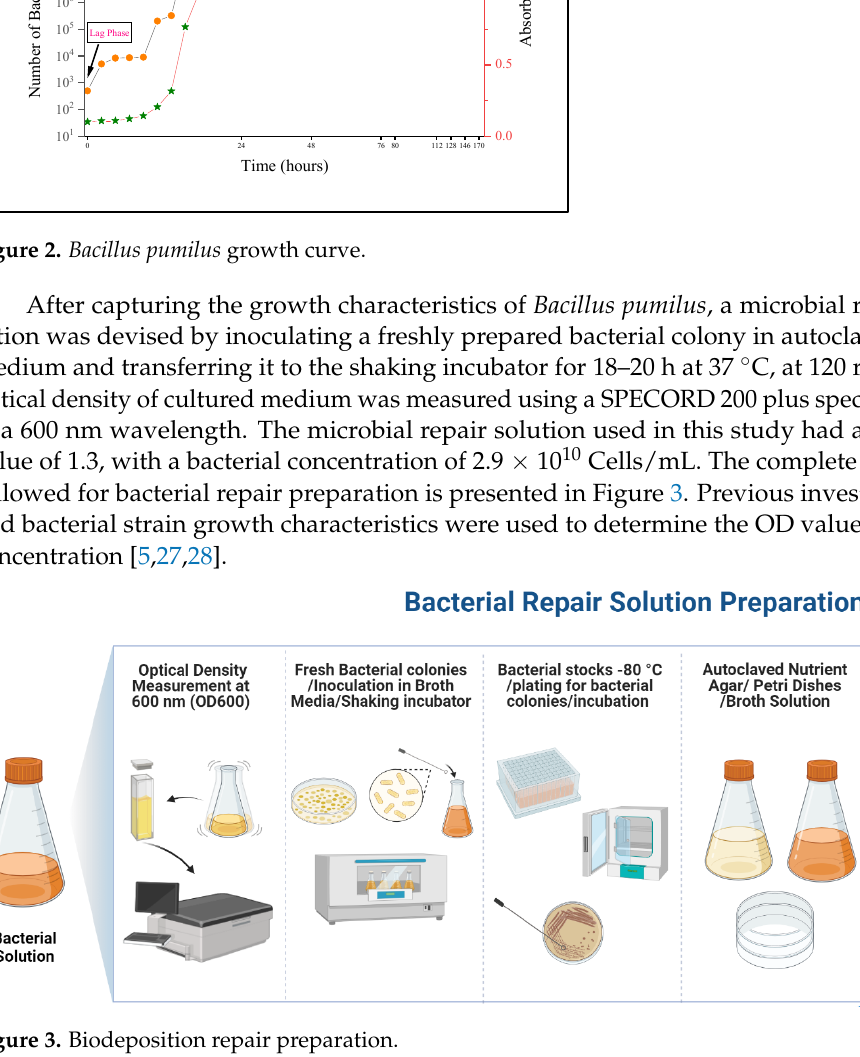
Figure 2. Bacillus pumilus growth curve.